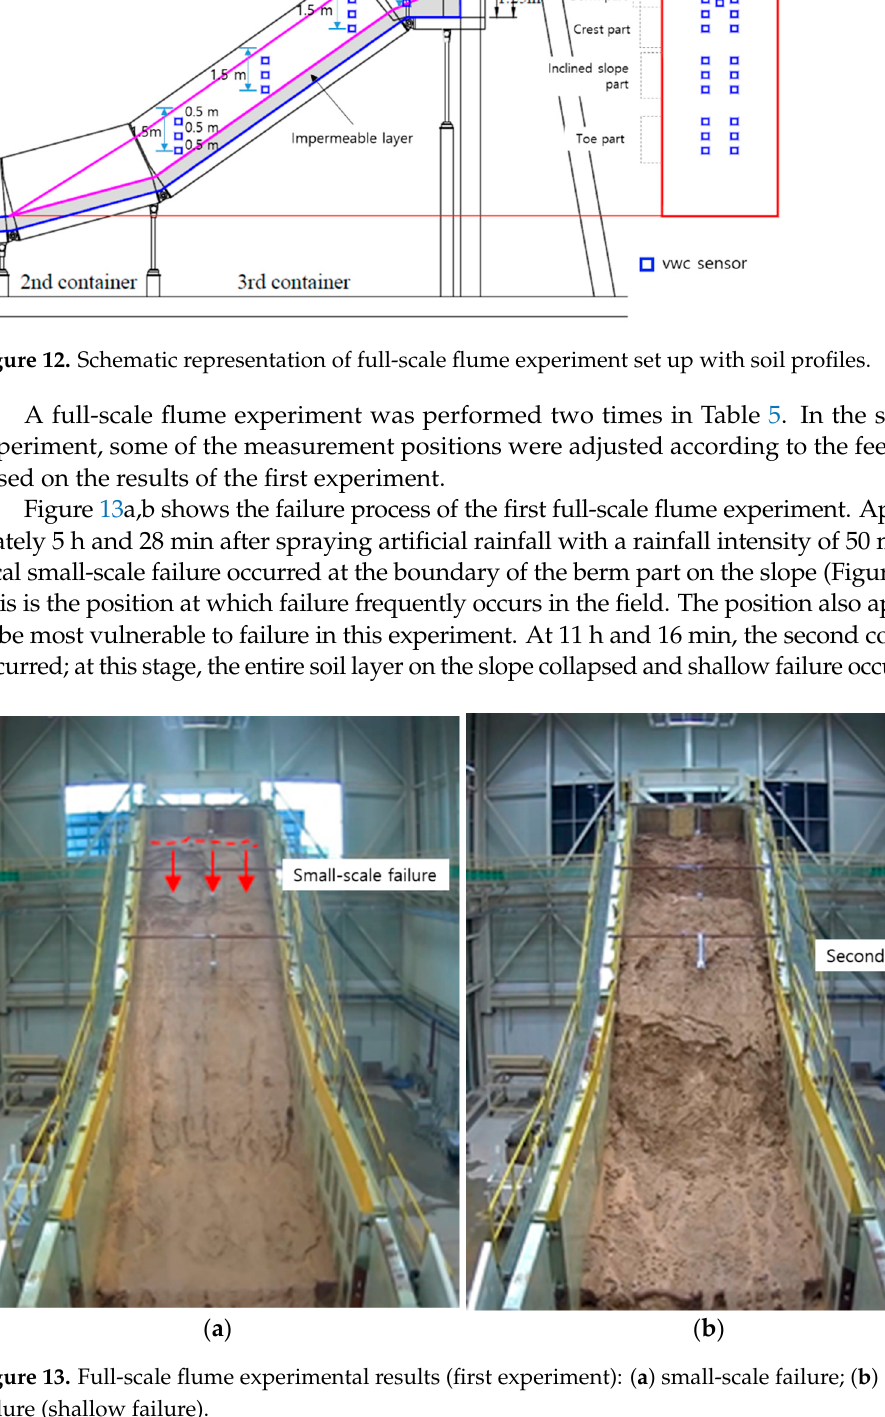
Table 5. Soil condition and positions of sensors for full-scale flume experiments.